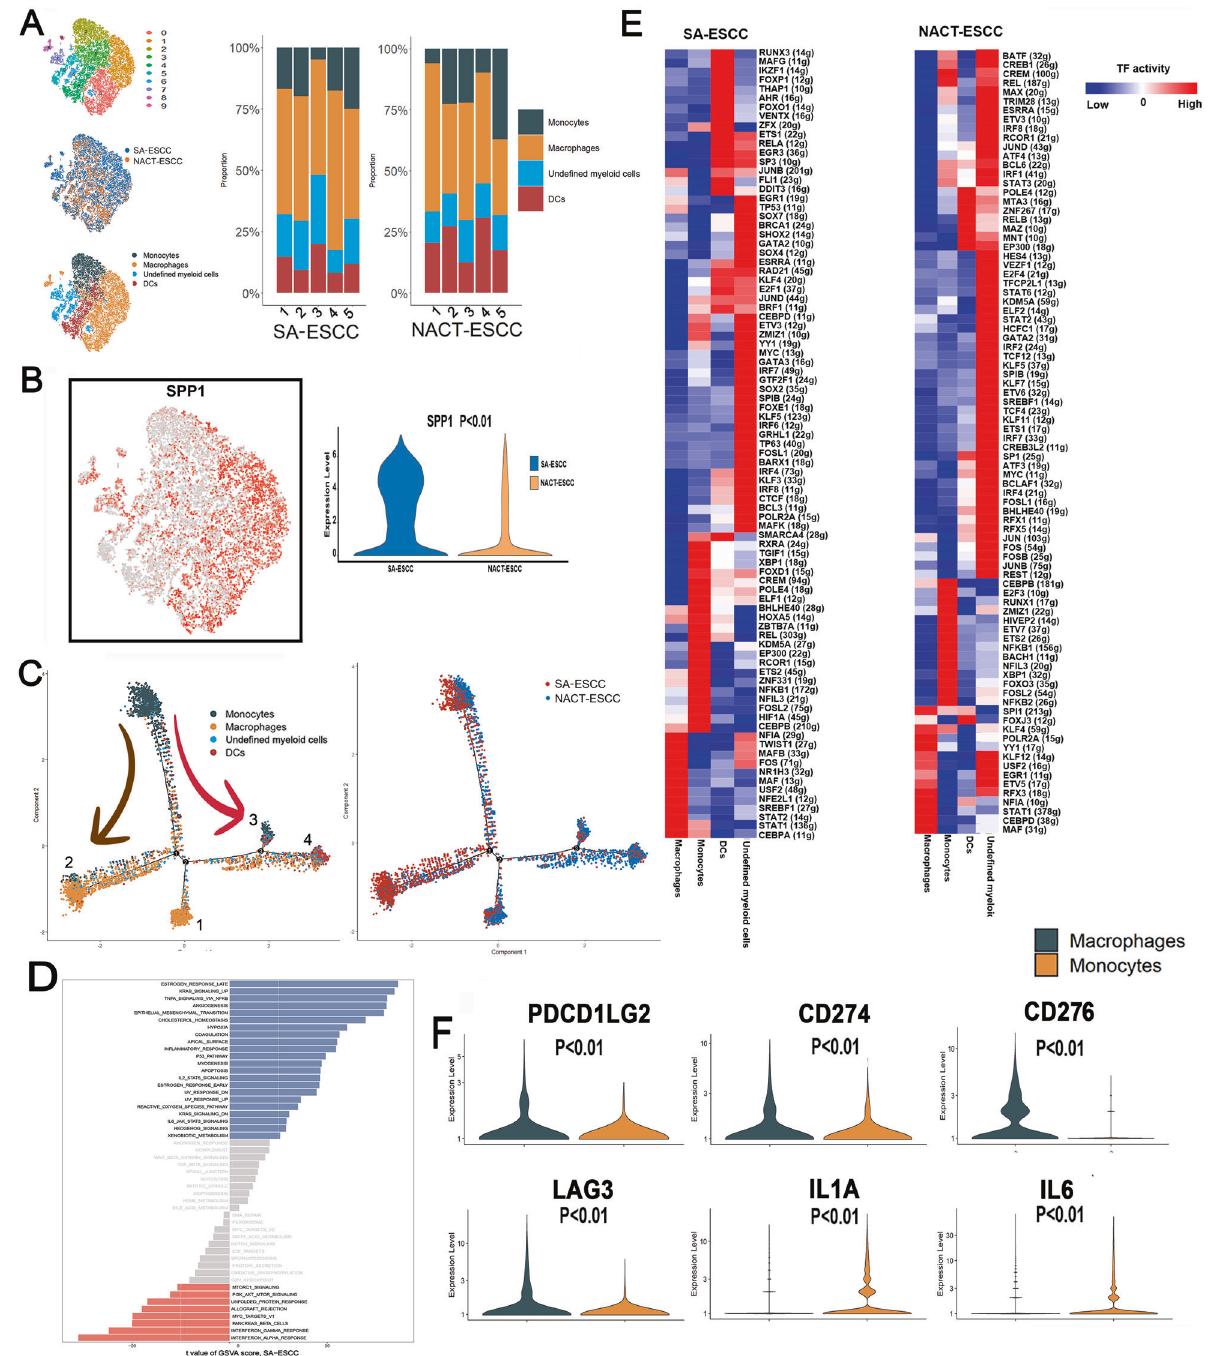
Fig. 5 The scRNA Pro fi les for myeloid cells in SA-ESCC and NACT-ESCC. A The TSNE plot and the proportion of myeloid cells in SA-ESC and NACT-ESCC samples. B Feature plot and violin plot of SPP1. C Potential developmental trajectory of myeloid cells inferred by analysis with Monocle2. D Differences in pathway activities scored per cell by GSVA among macrophages in SA-ESCC and NACT-ESCC conditions. Normalized pathways scores. E Heatmap showing the activity of TFs in each myeloid cell subtypes in NACT-ESCC and SA-ESCC, respectively. The TF activity is scored using AUCell. F Violin plots of immune checkpoints upregulated or downregulated between monocytes and macrophages